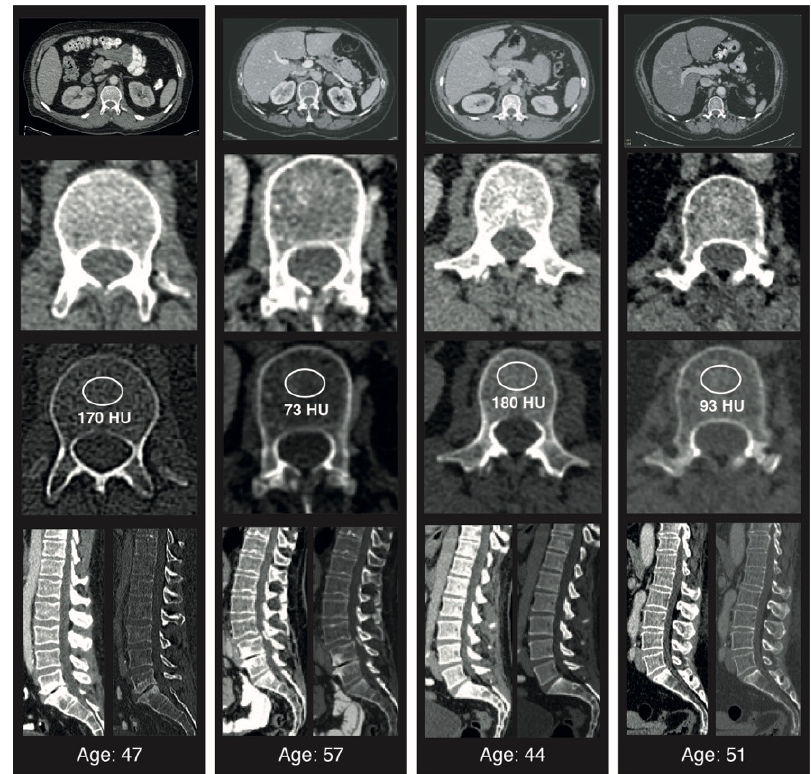
Figure 1. Examples of trabecular L1 attenuation assessment at CT. Transverse (axial) CT scans at the L1 level in adult patients of varying ages and with different average Hounsfield units at the time of diagnosis. Standard placement of the region of interest (ROI) for trabecular attenuation measurement and the mean Hounsfield unit value within the ROI are shown. Sagittal reconstructions with soft tissue and bone windows are shown.